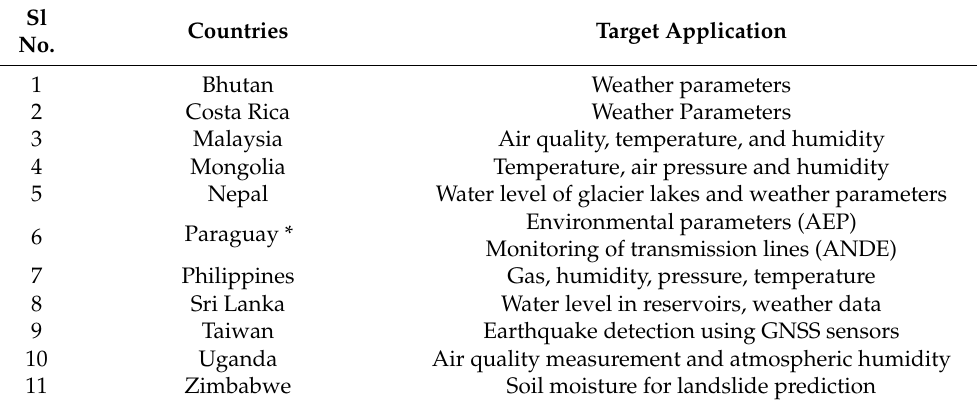
Table 6. The countries participating in S&F IoT mission in alphabetical order.